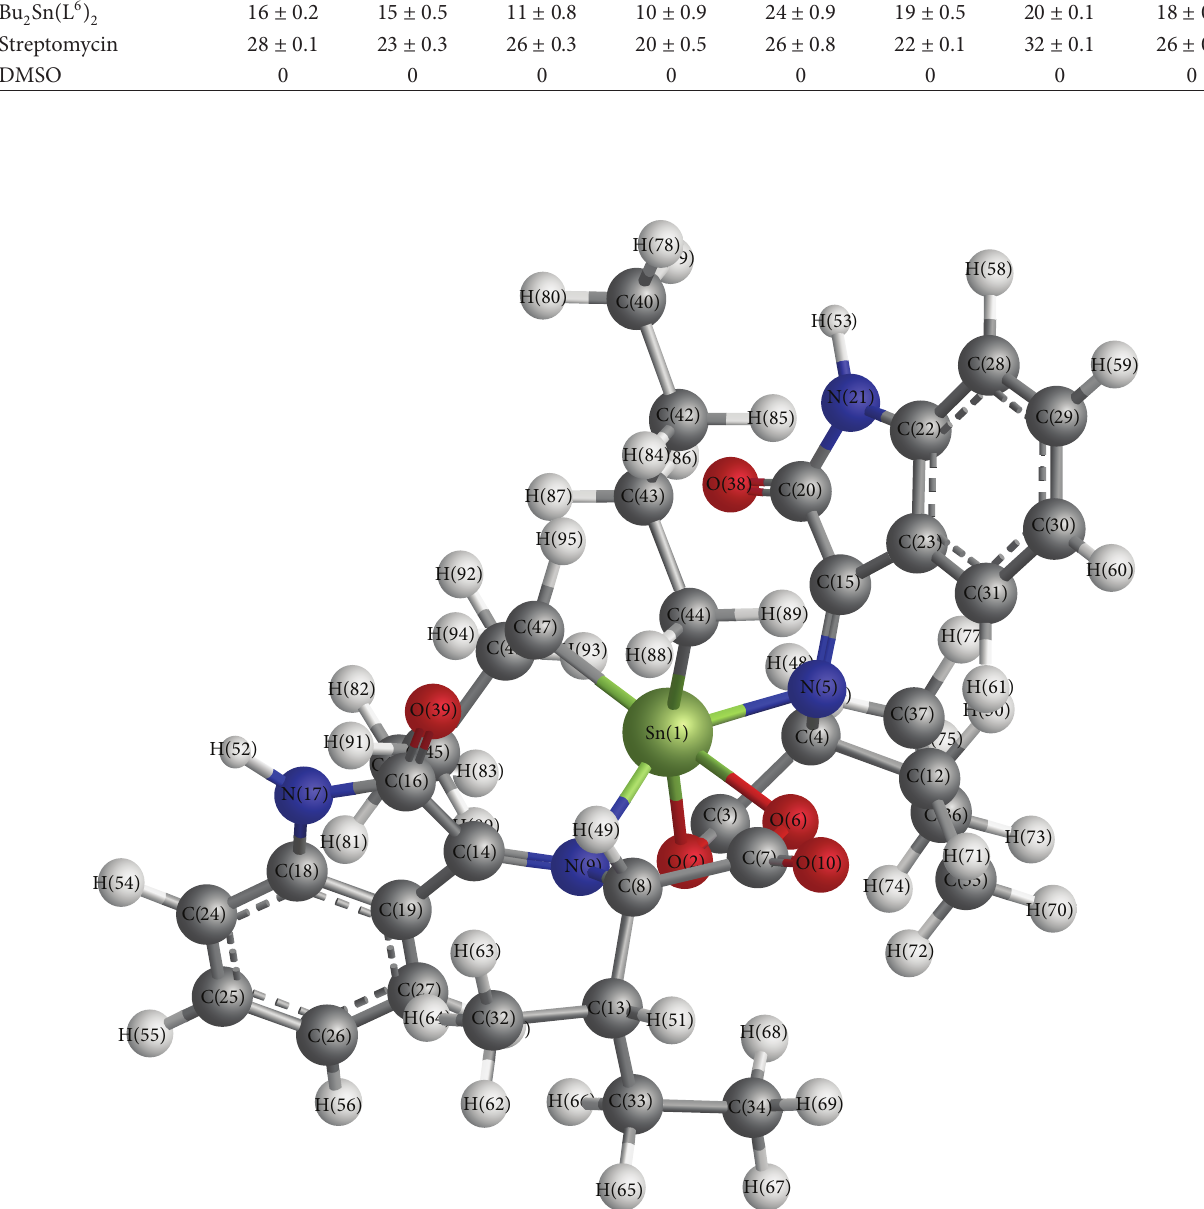
Schiff bases/complexes